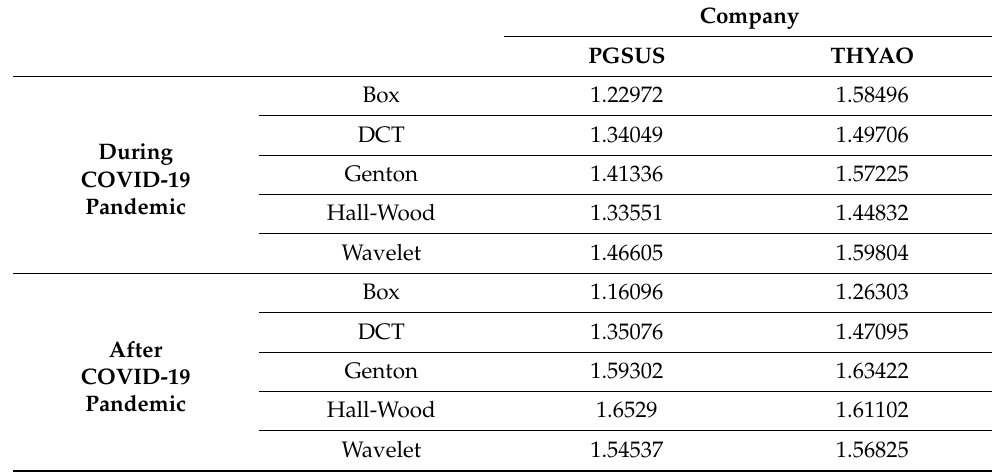
Table A14. Fractal dimensions for the transportation